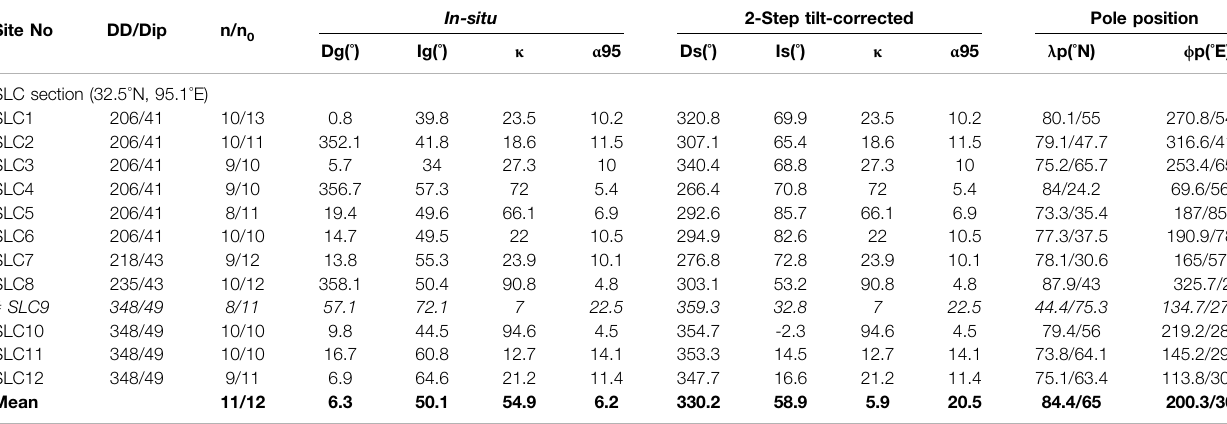
TABLE 1 | Characteristic remanent magnetization (ChRM) direction of the SLC site. Site